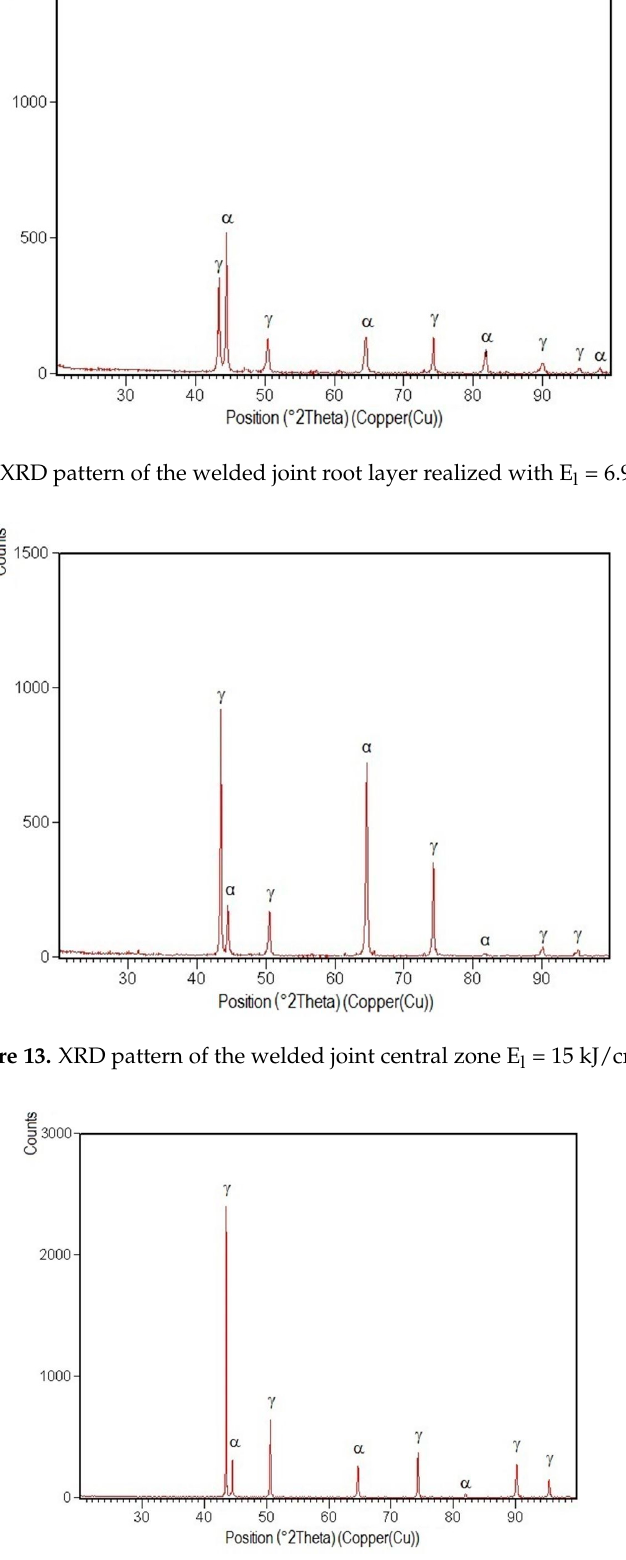
Figure 14. XRD pattern of the welded joint filling layer realized with E l = 15 kJ/cm.